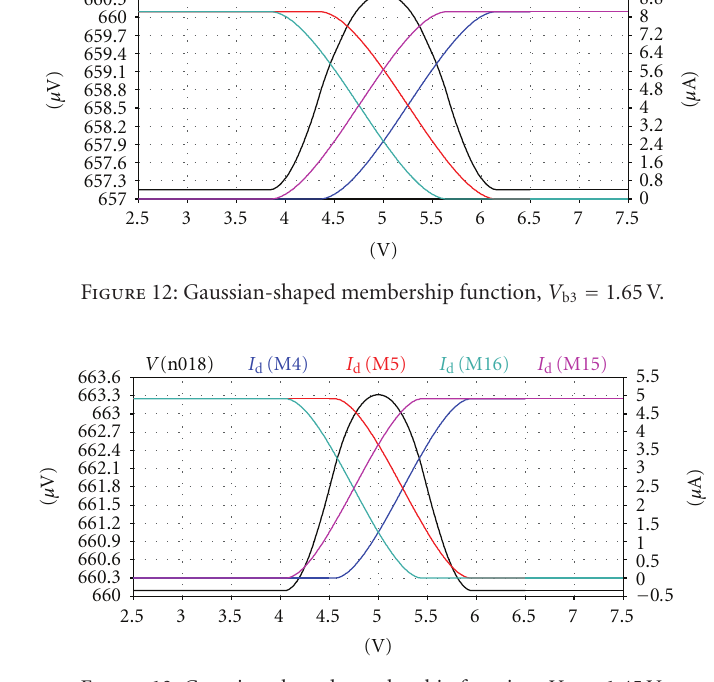
Figure 13: Gaussian-shaped membership function, V b3 = 1 . 45